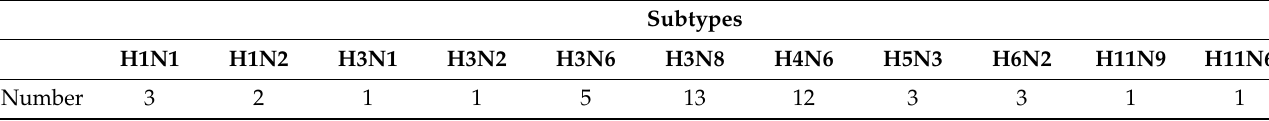
Table 2. Number of viruses of different subtypes among Moscow isolates.